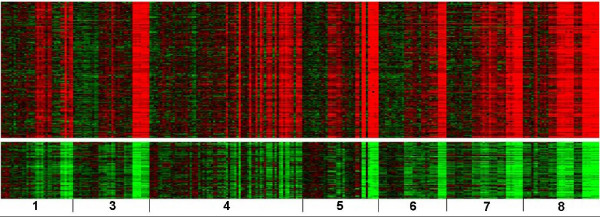
Heat maps of two biclusters from samples exposed to hepatotoxicants and genes correlated with ALT. (A) 182 genes up-regulated in the top half and (B) 76 genes down-regulated in the bottom half were significantly correlated and anti-correlated to the ALT profile respectively. From left to right are (1) 1,2-dichlorobenzene, (3) bromobenzene, (4) diquat dibromide, (5) galactosamine, (6) monocrotaline, (7) N-nitrosomorpholine and (8) thioacetamide. Note that 1,4-dichlorobenzene was excluded from these two biclusters. The doses and time points have the same order as in Figure 1.